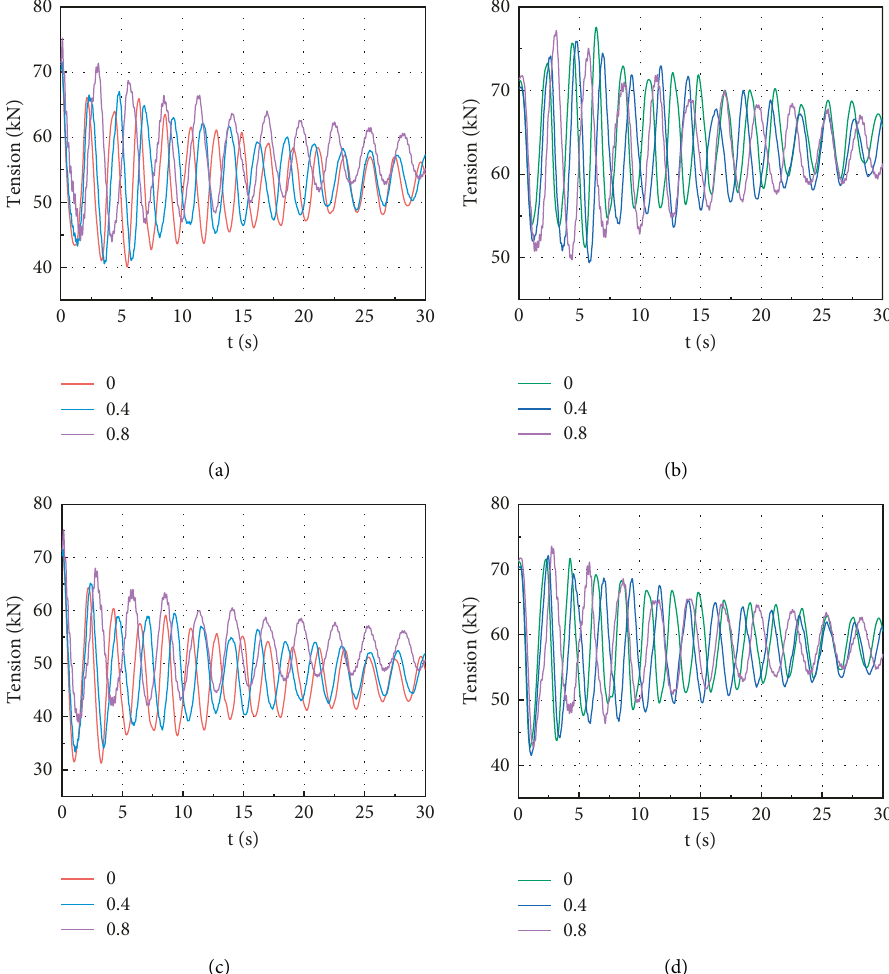
Figure 12: Tension-time curves of subconductor with different height difference ratios: (a) A1 conductor, (b) A2 conductor, (c) A3 conductor, (d) A4 conductor.